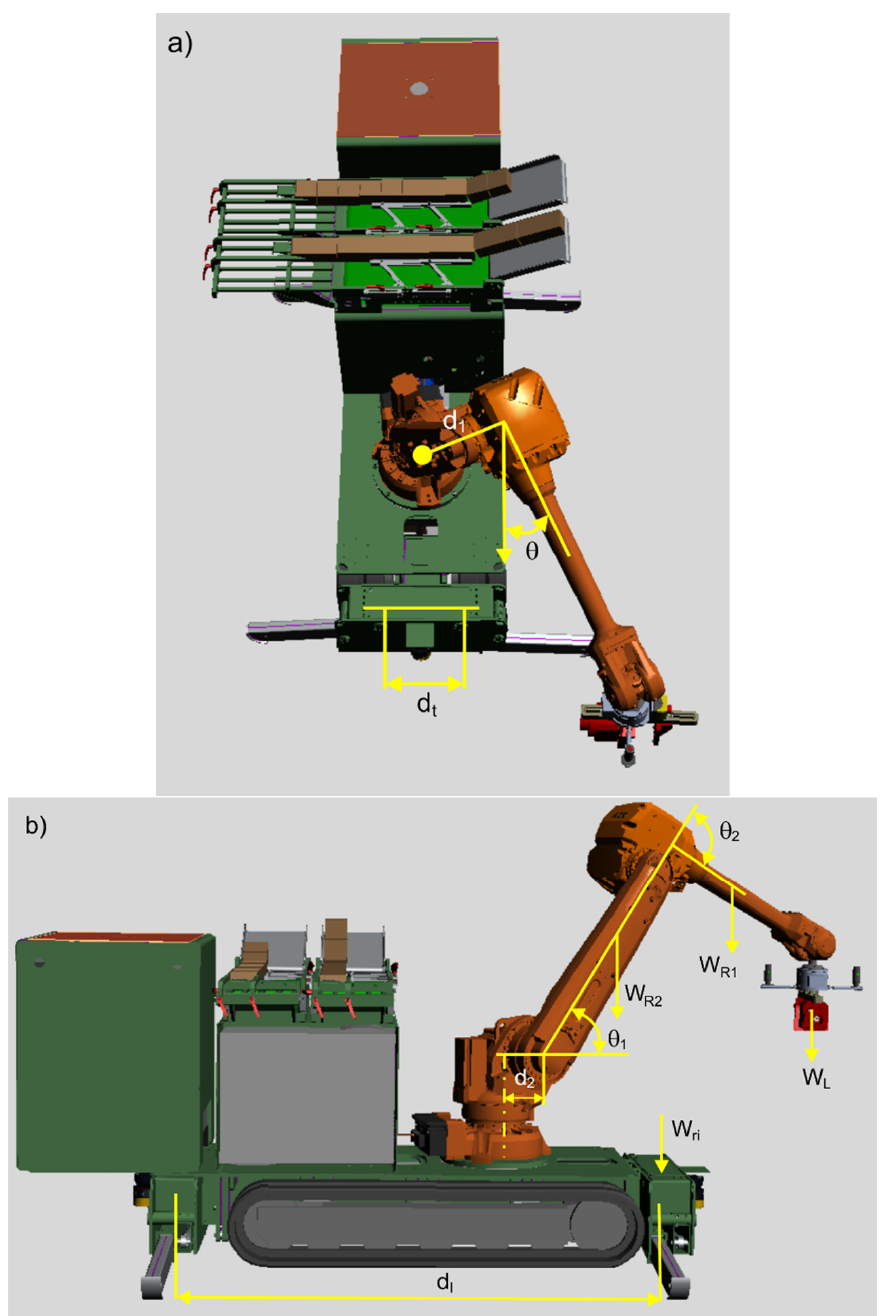
Figure 9. Marking on the bricklaying robot of the mass loads influencing the forces acting on the hydraulic lifting actuators: ( a ) top view of the RBS structure, ( b ) side view of the RBS structure.